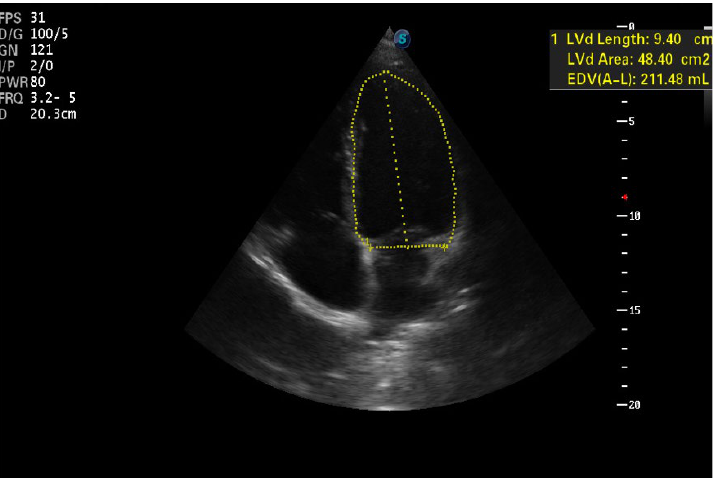
Figure 6. Case 2—TTE showing tele-diastolic LV volume evaluation (yellow dotted line).